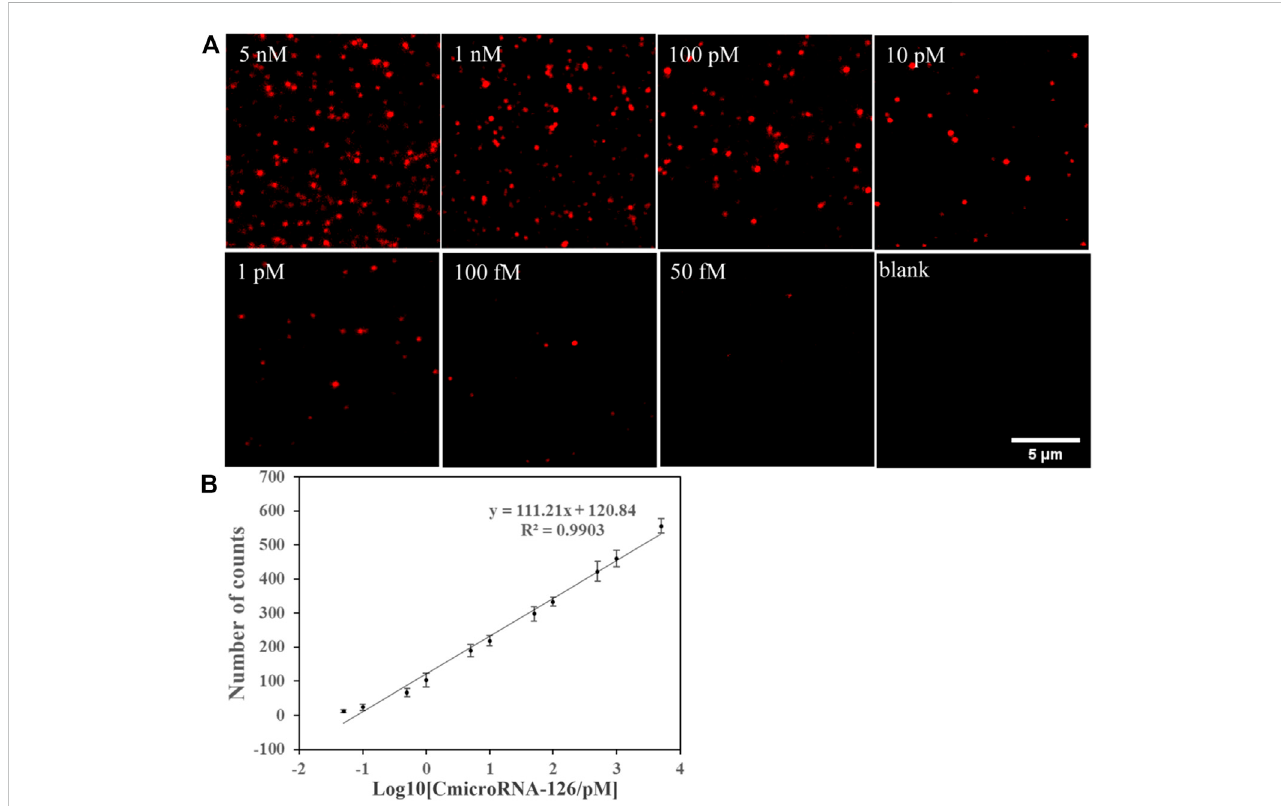
FIGURE 2 (A) Single-molecule fl uorescence imaging method was used to detect miR-126 in a series of concentrations of miR-126 samples to fi nd the detection limit. (A) Representative Cy5 spots image. (B) Correlation between Cy5 spot counts and the logarithm of miR-126 sample concentrations; Scale bar: 5 μ m; Error bars indicate the standard deviation of three experiments.